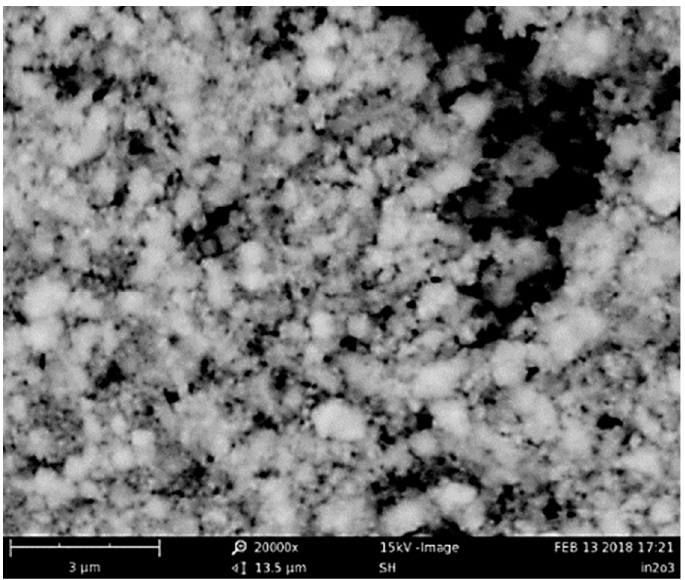
Figure 2. Scanning Electron Microscopy (SEM) image of the prepared In 2 O 3 .